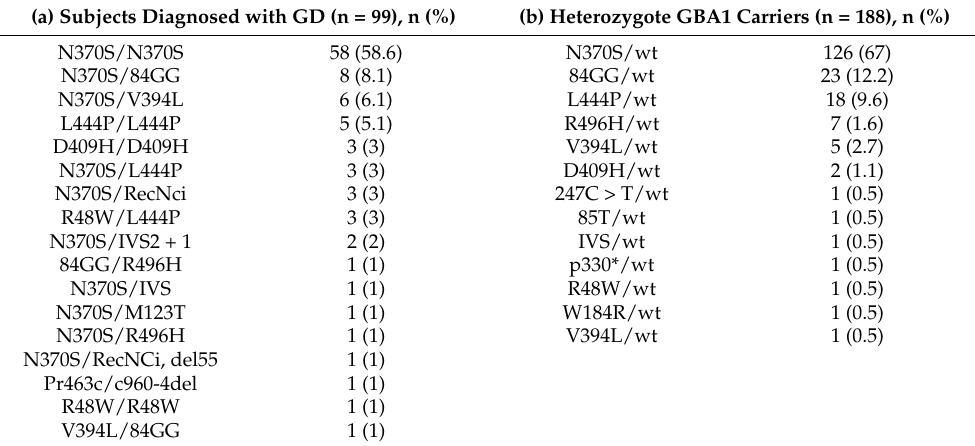
Table 2. Distribution of genotypes in subjects with or without the diagnosis of Gaucher disease.